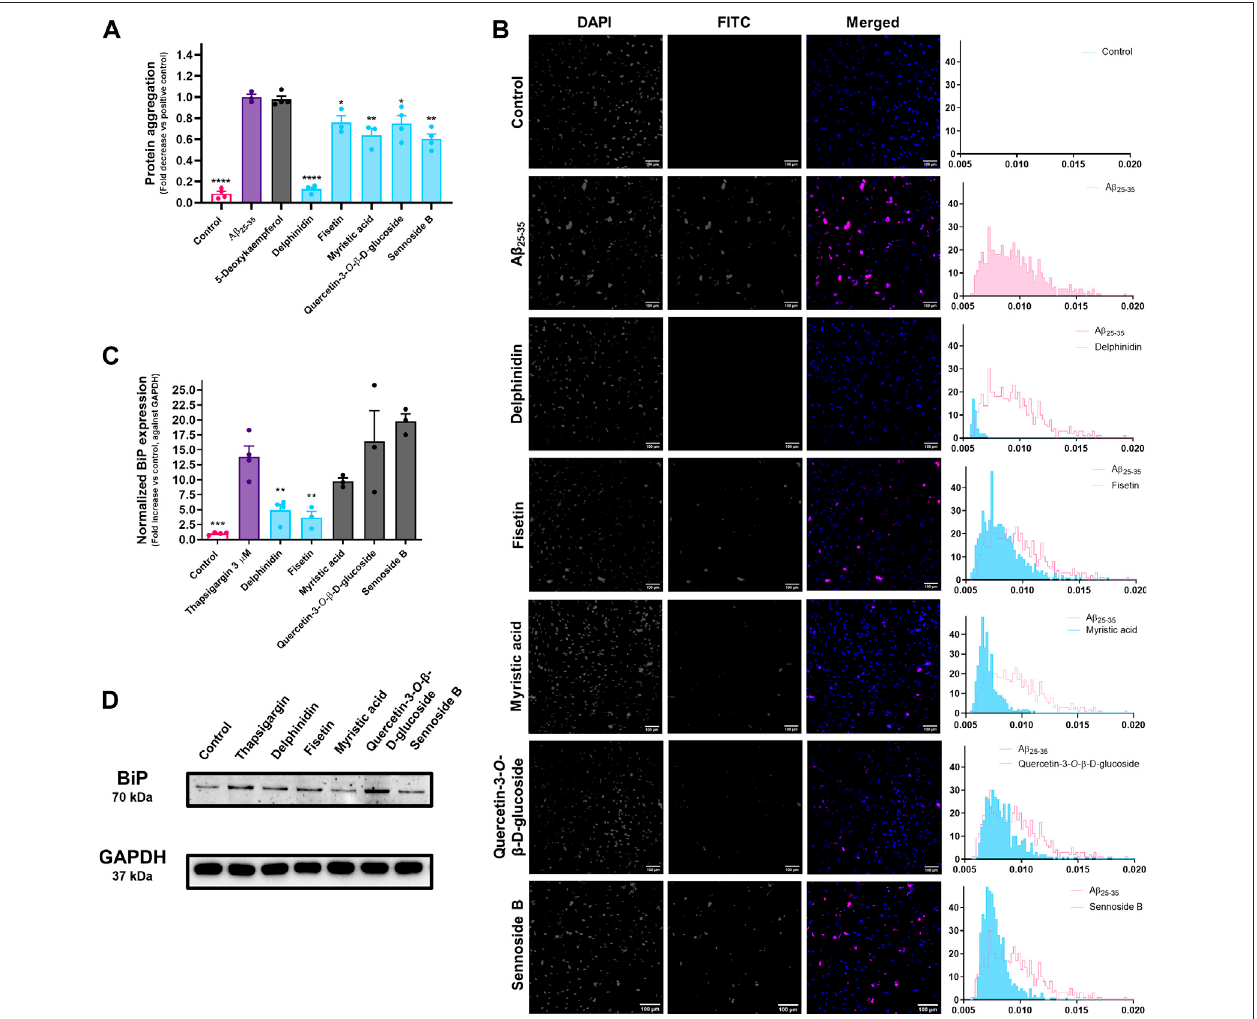
FIGURE 5 |(A) Impact of delphinidin, fi setin, myristic acid, sennoside B and quercetin-3- O - β -D-glucoside on A β 25-35 -induced protein aggregation in MRC-5 cells, determined by the fl uorescence of thio fl avin T. Results correspond to the mean ± standard error of the mean of, at least, three independent experiments, individually performed in triplicate. (B) The protective effect of bioactive molecules was captured under a fl uorescence microscope. The fl uorescence signal of thio fl avin T is represented in the histograms. (C) Effectof delphinidin on Tg-induced BiPexpression in MRC-5 cells, as evaluated by Western blotting. Resultscorrespondto the mean ± standard error of the mean of, at least, three independent experiments. (D) Images obtained through Western blotting analysis.